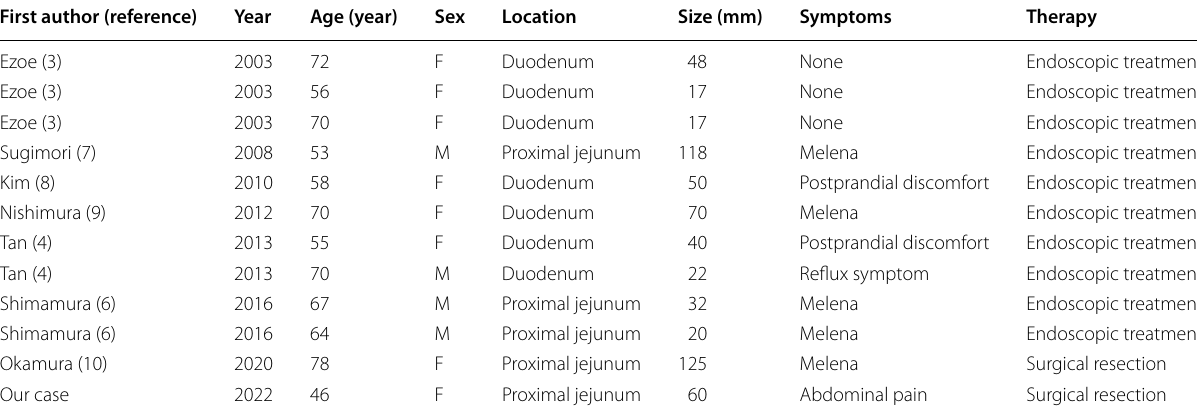
Fig. 6 Histopathological findings. a Hematoxylin–eosin staining (original magnification: submucosa. b Hematoxylin–eosin staining (original magnification: with prominent vascular and lymphatic